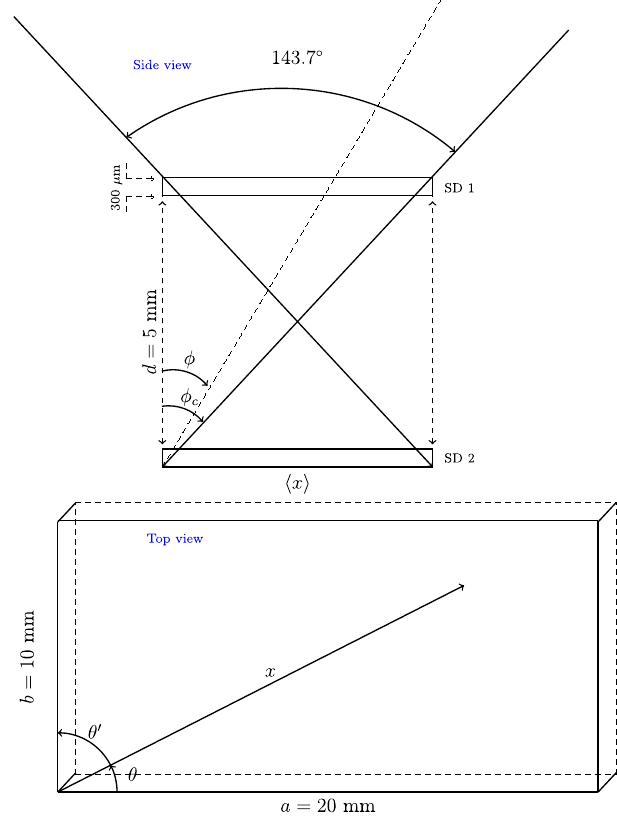
Figure A.5. The s2744-08 Hamamatsu diodes in telescope mode. The top panel shows a side-on view and the SD ’ s orientation, while the lower panel shows a top view of SD